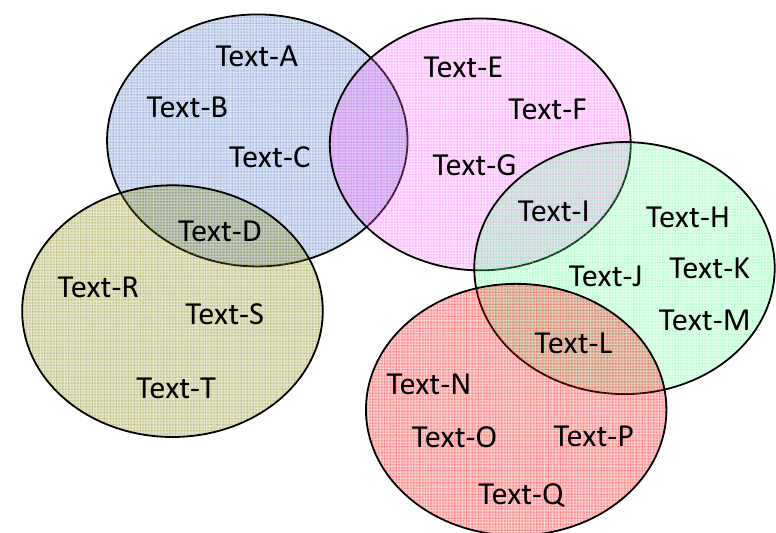
Figure 8. Graph-type database that enables the easy addition of a graph ( a ) and easy expansion of academic fields ( b ), where different colors indicate different academic fields such as materials mechanics, solid-state physics, and chemical thermodynamics.